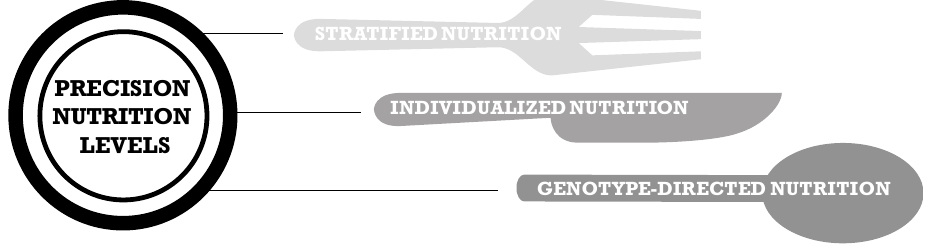
Figure 2. The three levels of precision nutrition according to the International Society of Nutrigenetics/Nutrigenomics (ISNN) [29].